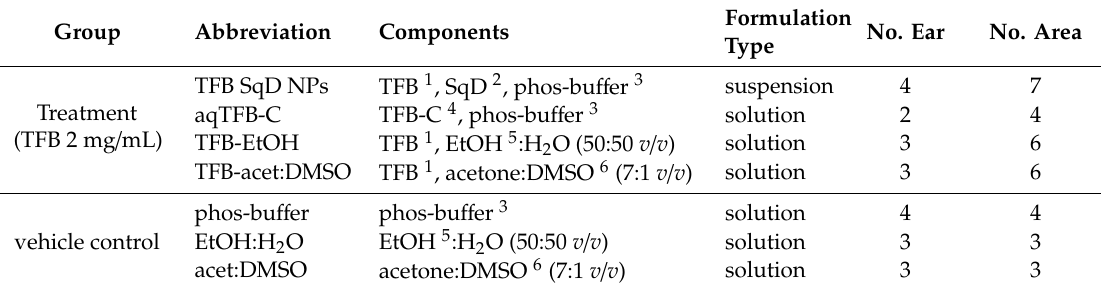
Table 1. Abbreviation, composition, formulation type, number of pig ears, and number of application areas used for ex vivo pig ear study on topical penetration and permeation